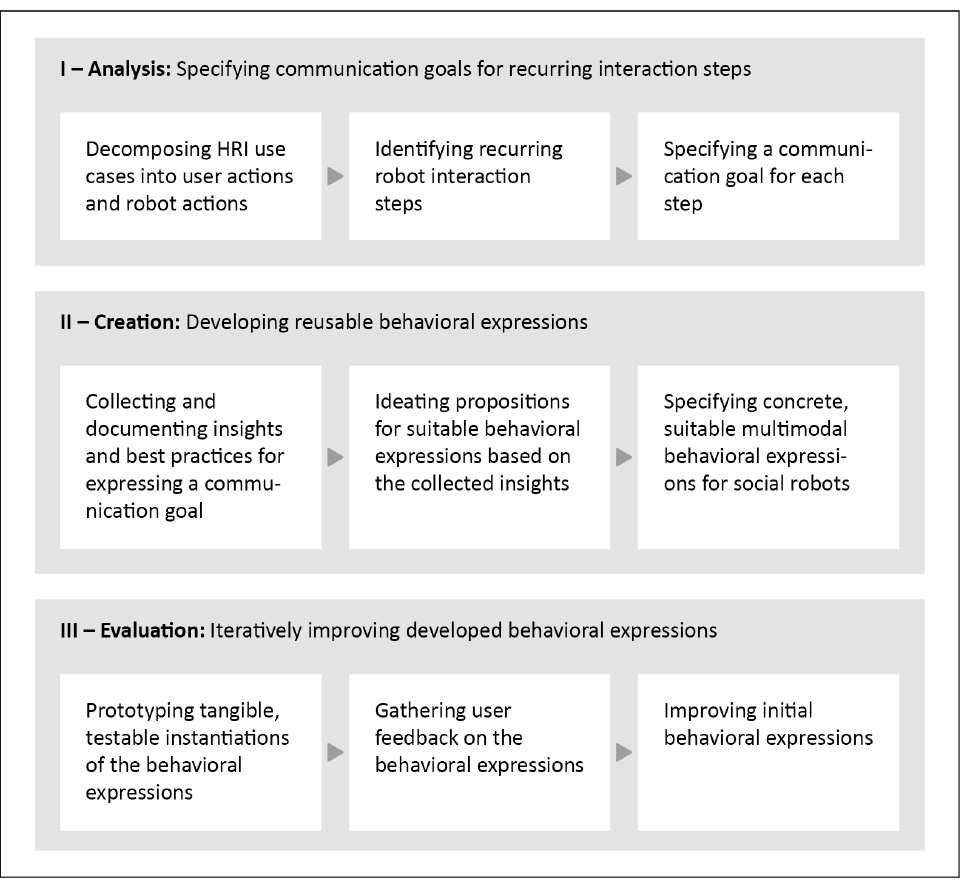
Figure 1. The three phases and nine steps of the pattern design